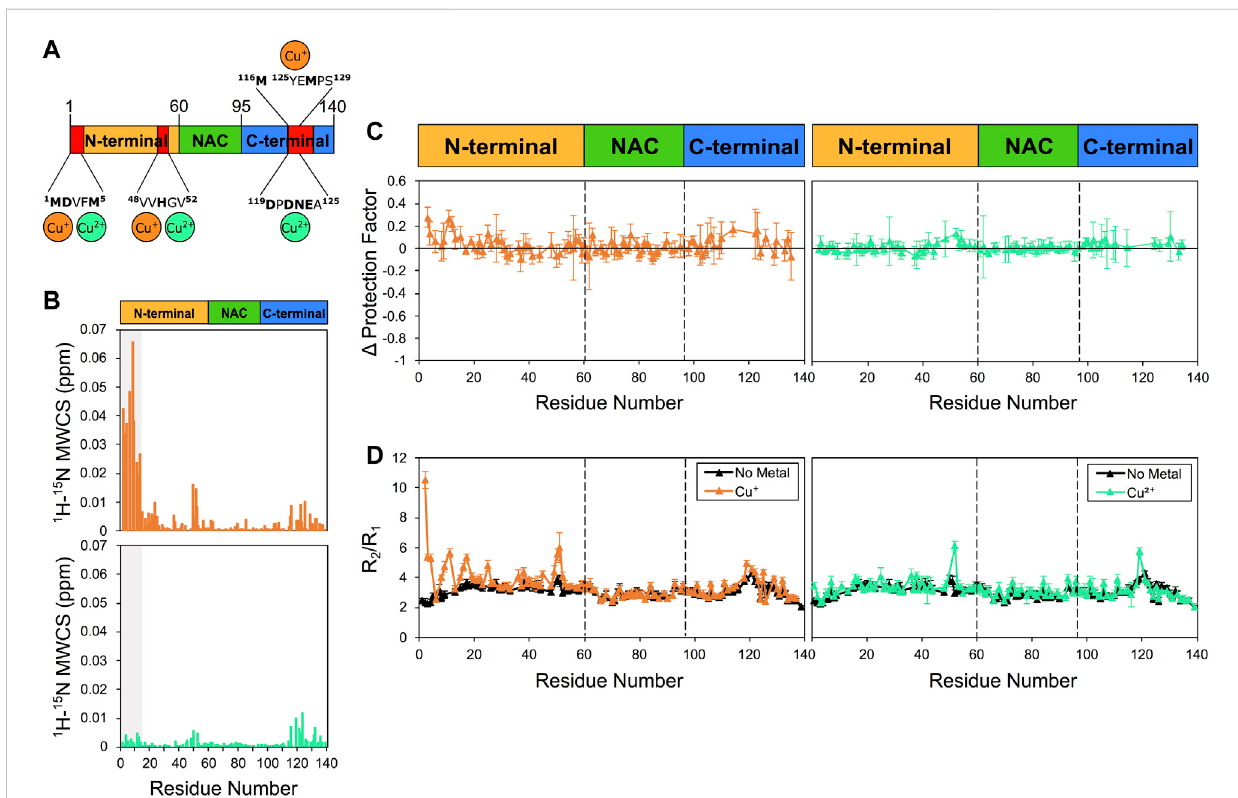
FIGURE 2 NMRanalysis of copperbinding to α S.Experimentswereperformed at10 ° Cin25 mM TrisbufferandapHof7.0, andusing concentrations of α Sand Cu + (orCu 2+ )of415 μ Mand85 μ M,respectively. (A) SchematicdepictingCu + andCu 2+ bindingby α S.RedregionsintheschemeindicatemajorCSPalong the α S sequence upon metal binding. (B) Mean weighted CSP ( 1 H- 15 N MWCS) of α S as a result of the copper binding. Top and bottom panels for Cu + and Cu 2+ binding, respectively. The grey boxes denote the fi rst 15 residues of the protein. (C) Alteration in the LogP values of α S as a result of copper binding. Left and right panels for Cu + and Cu 2+ binding, respectively. These values are calculated for each α S residue as the logP of the metal bound state minus the logP of the isolated protein state. (D) R 2 /R 1 values from 15 N relaxation data of α S in the presence of Cu + (orange, left panel), Cu 2+ (green, right panel)andintheisolatedprotein(black)(rawdatainSupplementaryFigureS7).Errorbarsarecalculatedfromthe fi ttingerrorsinR 1 andR 2 measurements. Dotted lines delineate the different regions (N-terminal, NAC, and C-terminal) along the sequence of α